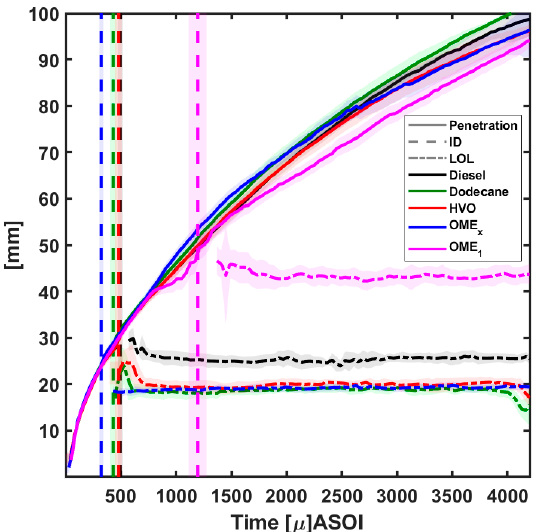
Figure 8. Spray tip penetration and lift-off length at 900 K 15% O2 and 1500 bar (Spray A condition by ECN). Vertical dashed lines represent ignition delay.